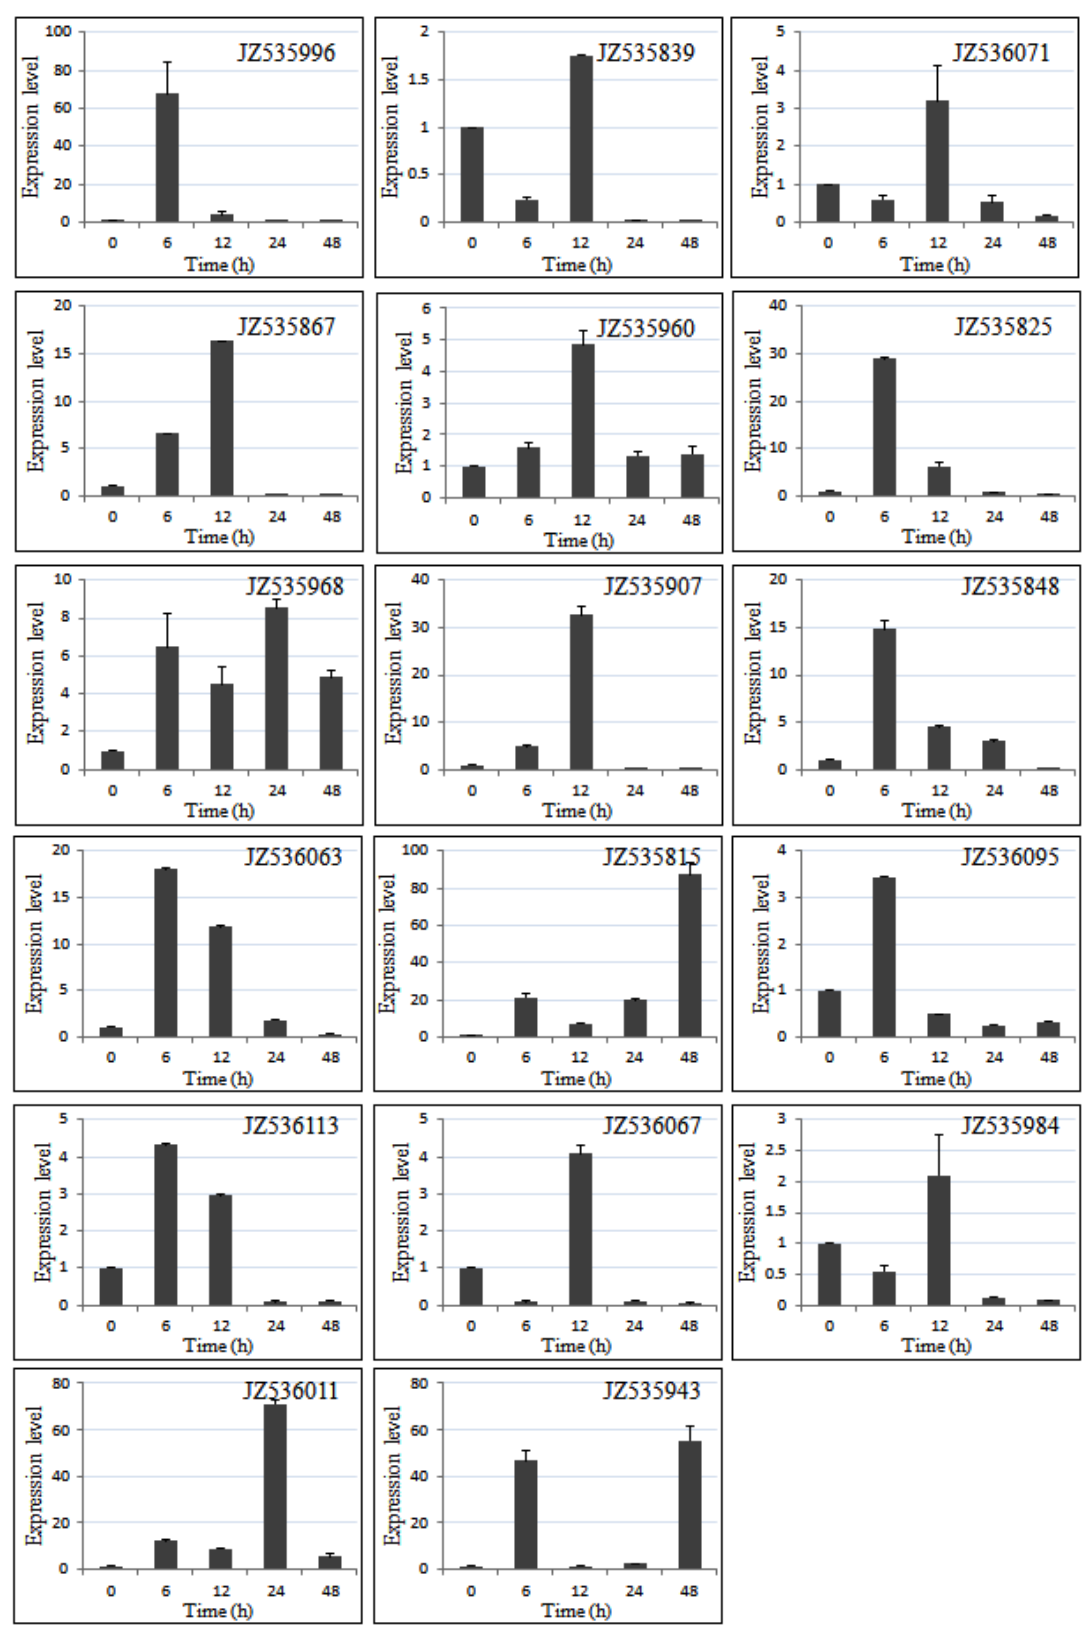
Figure 7. Quantitative RT-PCR validation of salt-related genes in the A. canescens with different times of 400 mM NaCl treatment. EF1α was used as internal control. The expression level means fold-changed obtained by quantitative